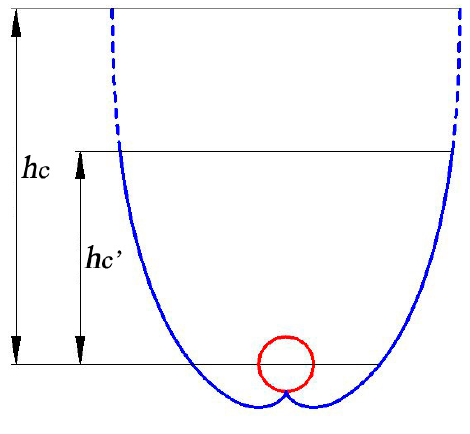
Figure 6. Schematic of truncated CPC.